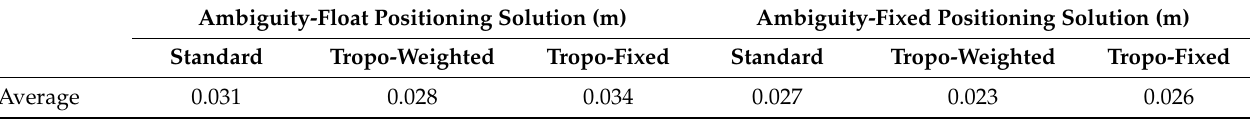
Table 3. Average RMS of the 3D positioning errors of ambiguity-float and -fixed solution at the user stations in the standard, tropospheric-weighted, and tropospheric-fixed model. Ambiguity-Float Positioning Solution